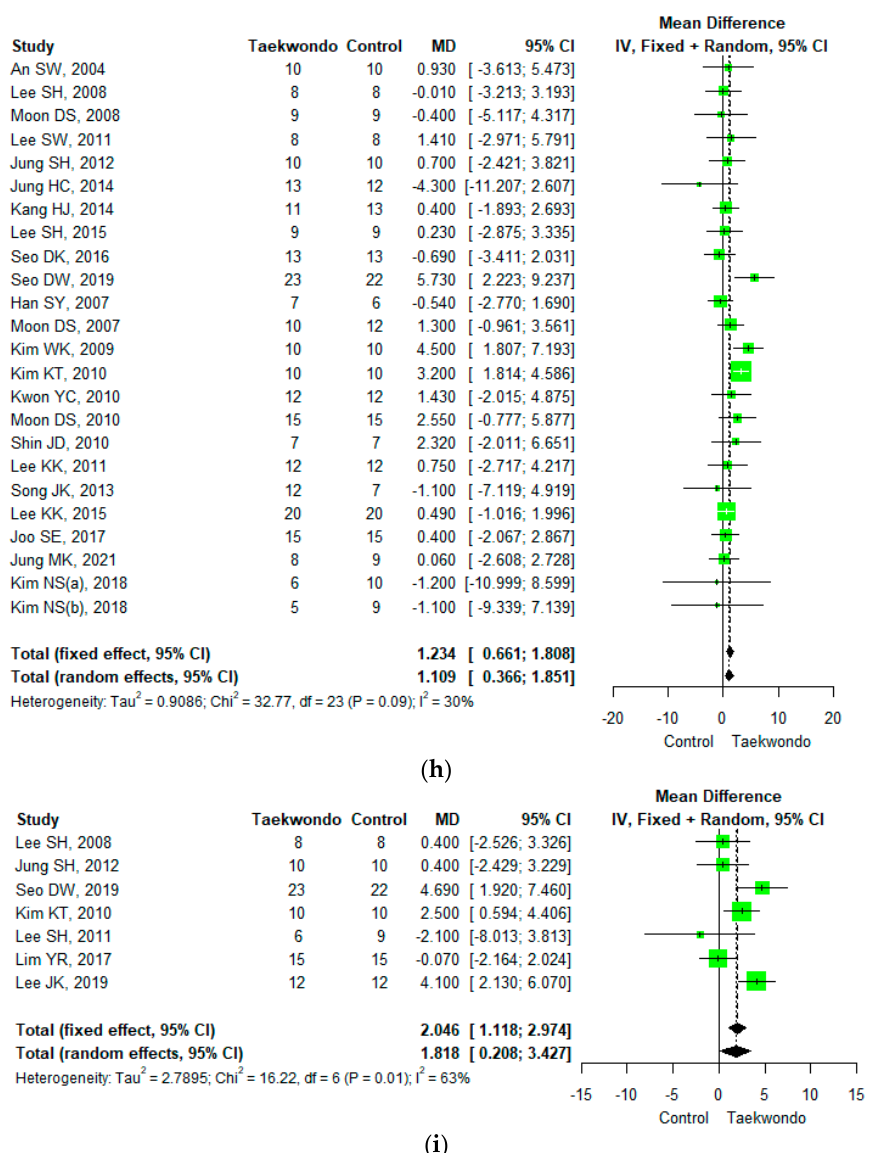
Figure 3. Forest plot of the mean difference in physique and body composition. ( a ) Height; ( b ) weight; ( c ) body mass index; ( d ) waist circumference; ( e ) waist-hip ratio; ( f ) body fat mass; ( g ) body fat percentage; ( h ) lean mass; ( i ) muscle mass.